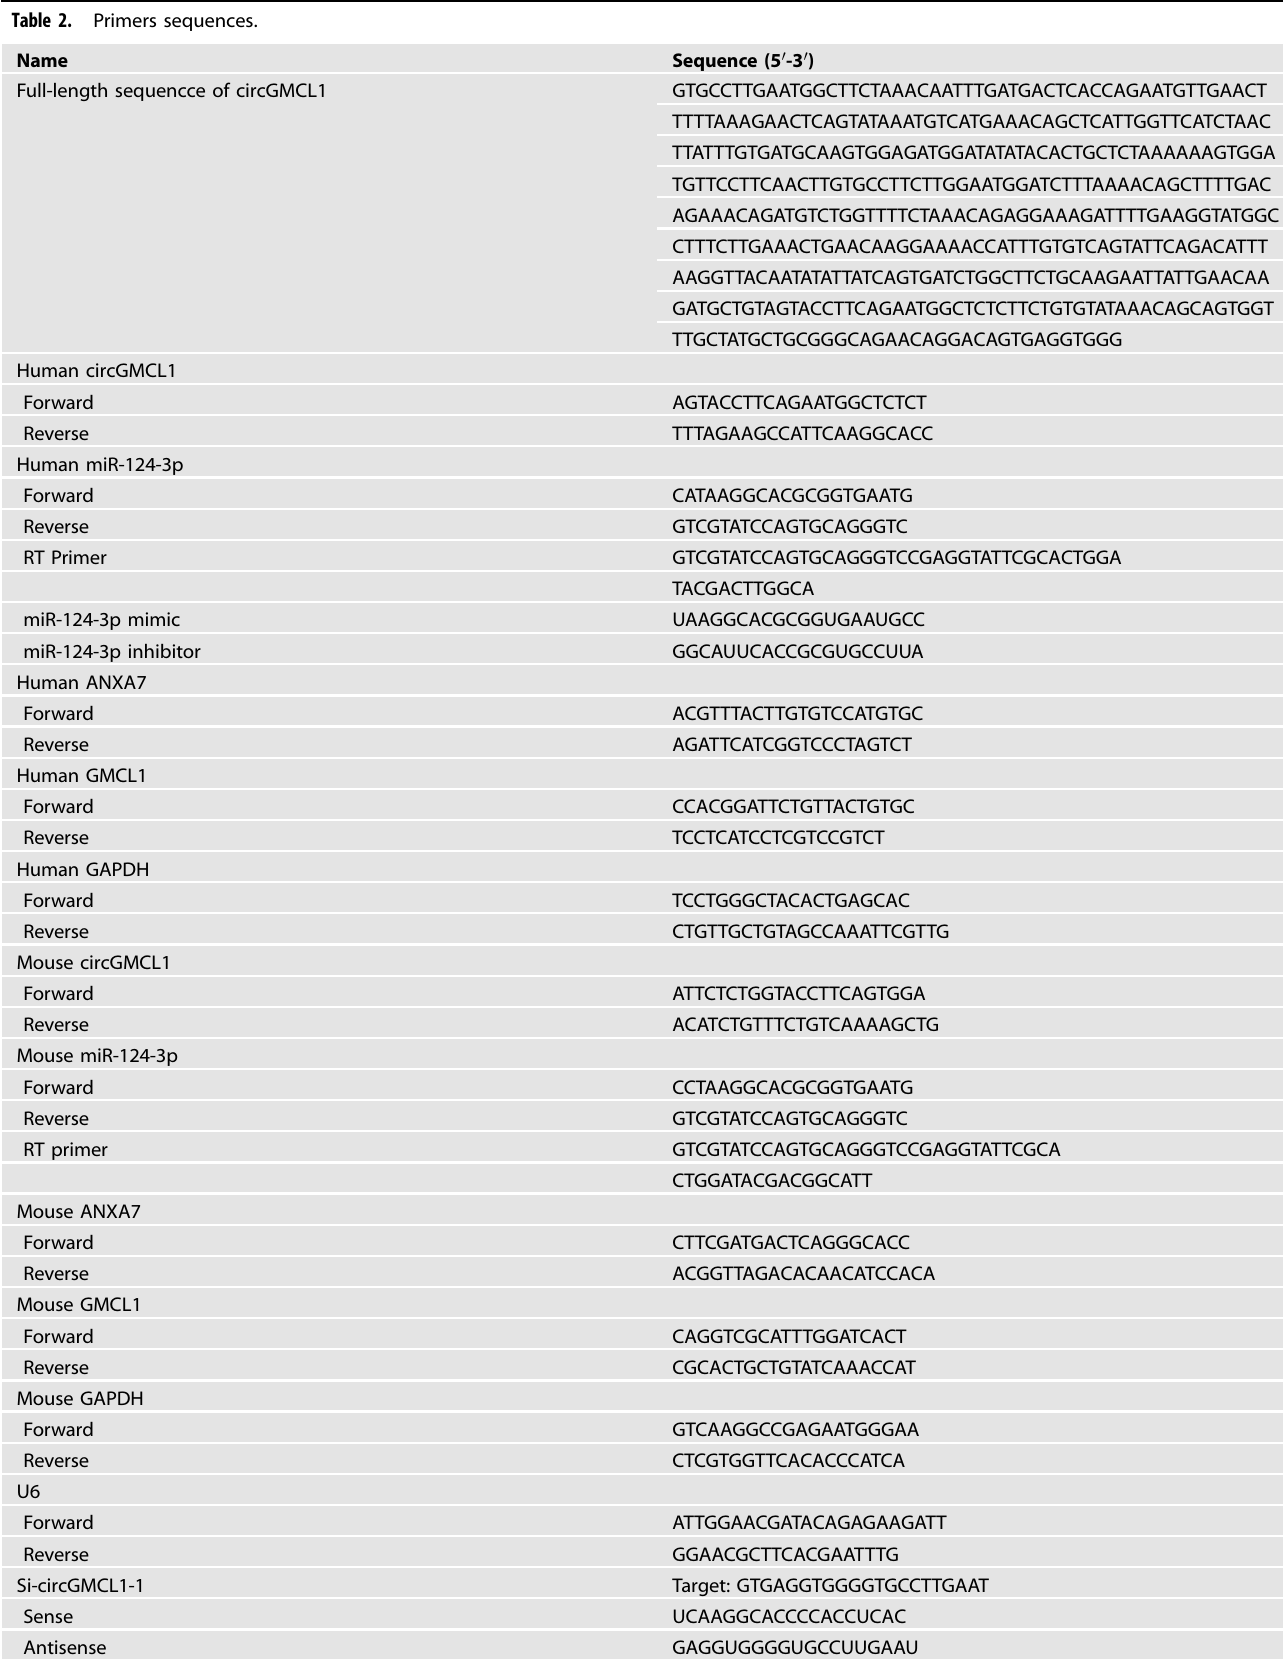
Table 2. Primers